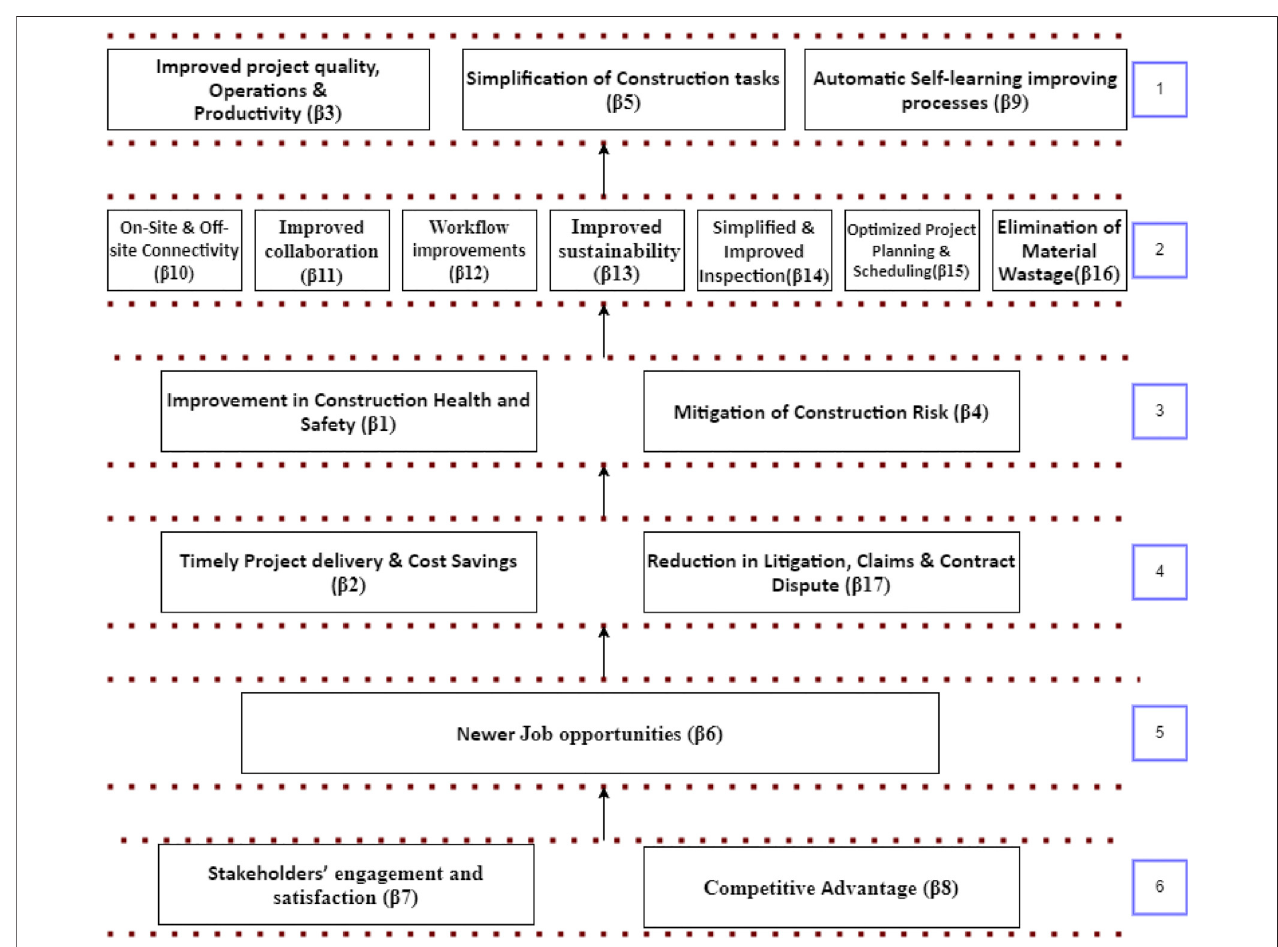
FIGURE 2 | ISM for bene fi ts of automation and arti fi cial